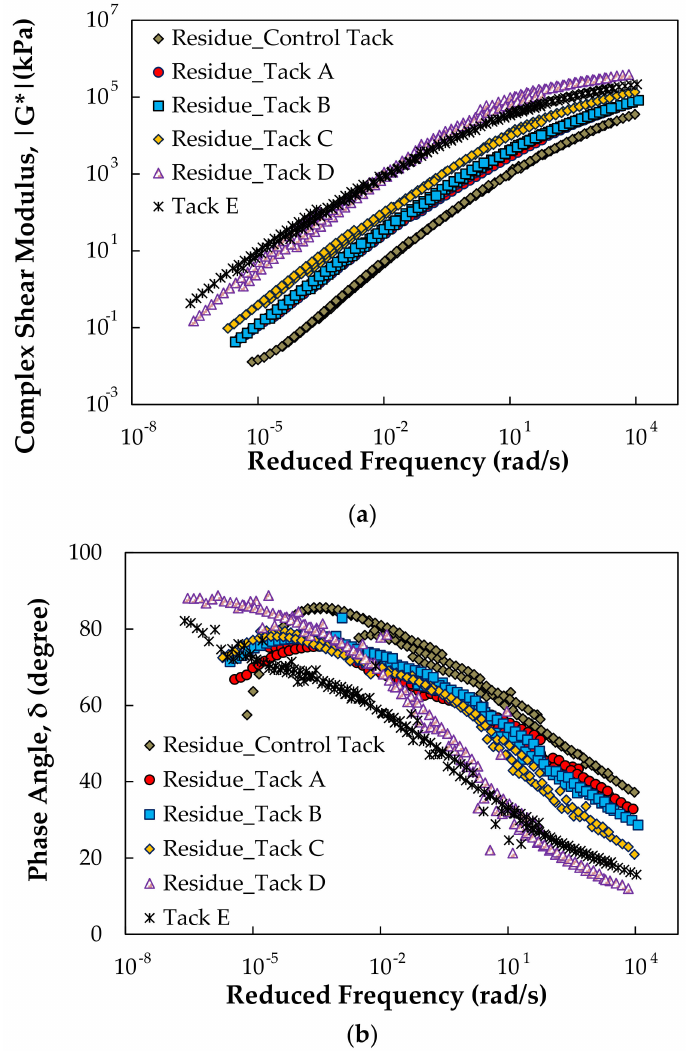
Figure 4. DSR frequency sweep test results for the residue of tack materials: ( a ) complex shear modulus and ( b ) phase angle master